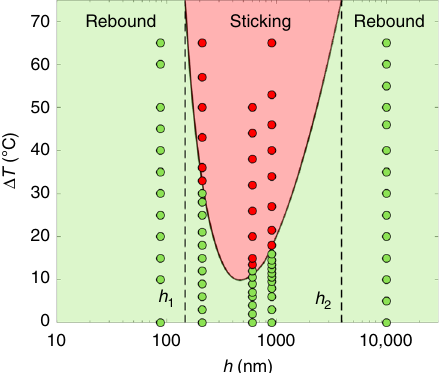
Fig. 4 Phase diagram for hot water impacting hydrophobic texture. The two control parameters are the water/substrate temperature difference Δ T and the pillar height h . The critical temperature Δ T c de fi ning the frontier between bouncing (green region) and sticking (red region) is calculated by solving ε = 0 in equation (5), with p = h , a = h /6, r ≈ 2, ε 0 = 0.2, R = 1.4 mm and V = 40 cm s − 1 , all values comparable to that in our experiments. The lower and upper bounds h 1 and h 2 for which bouncing is observed whatever the drop temperature are stressed with vertical dashes. Observations (green and red symbols for bouncing and sticking, respectively) are made for the fi ve tested samples (A, h = 88 nm; A ’ , h = 210 nm; B ’ , h = 600 nm; B, h = 900nm; C, h = 10 µ m) and found to be